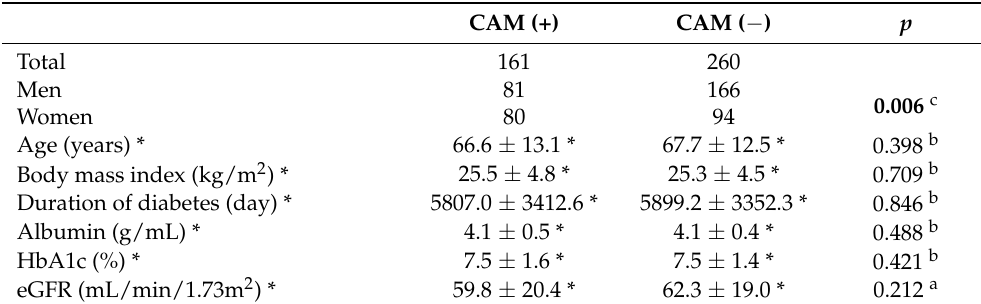
Table 4. Comparison of clinical profiles between type 2 diabetes mellitus patients with and without the use of